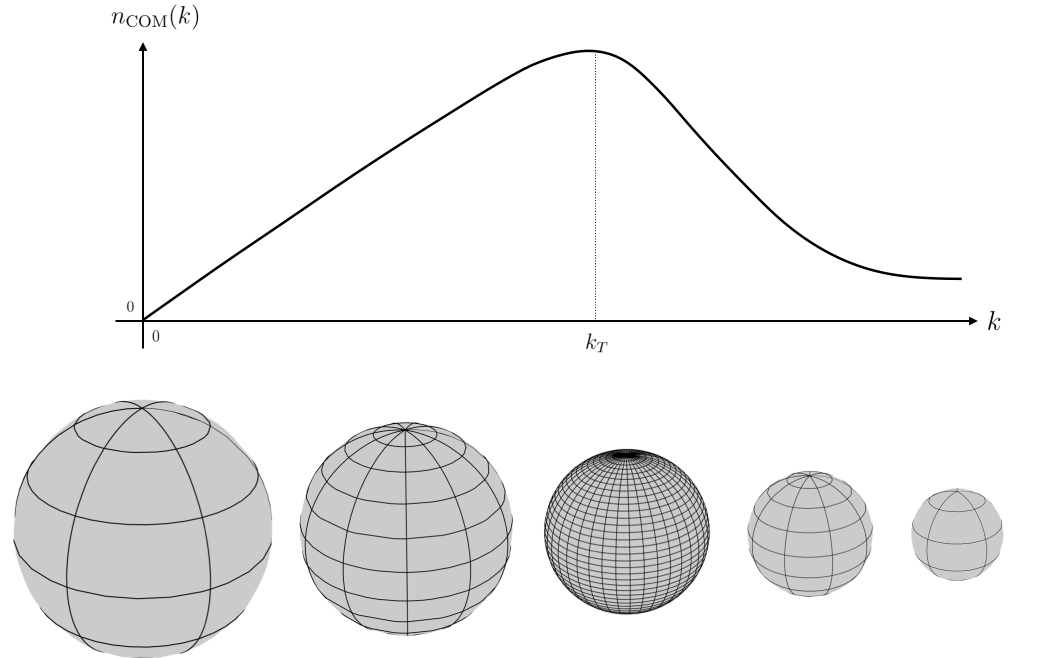
Figure 1. The principal quantum number of the cutoff modes, n COM , in dependence on the RG scale k . The size of the various spheres indicates the self-consistent radius L sc ( k ) at increasing values of k , and the coordinate grids shown visualize the (first increasing, then decreasing) angular resolving power of the spherical harmonics with n = n COM ( k )